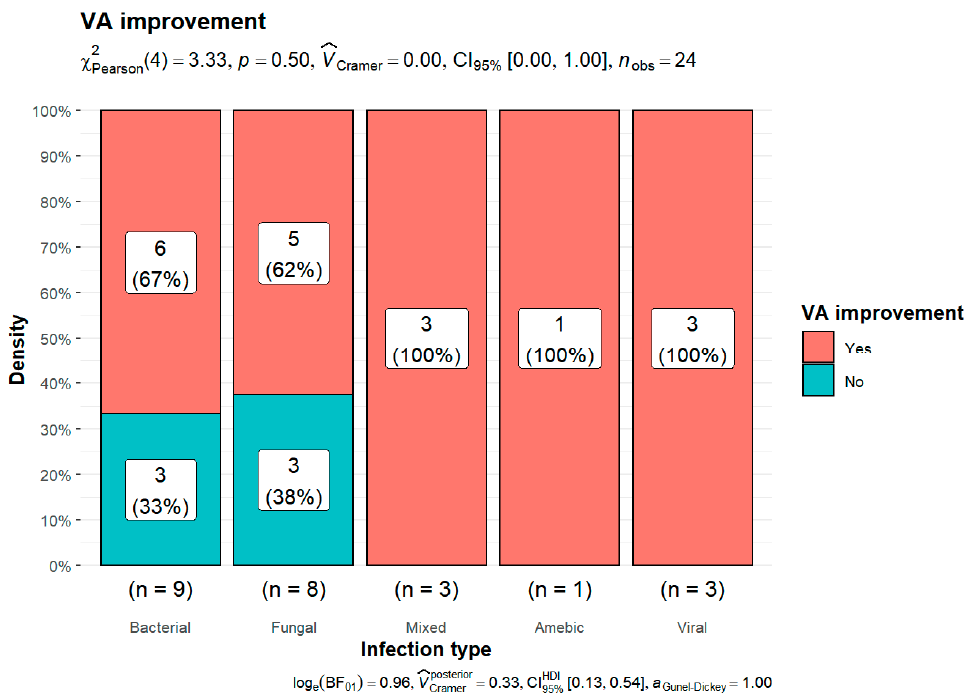
Figure 5. Improvement in VA and the type of infection.